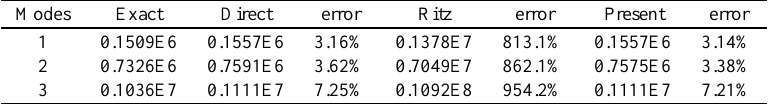
Fig. 1. Topological modifications of plate structure. Table 1 The eigenvalues of modified structure